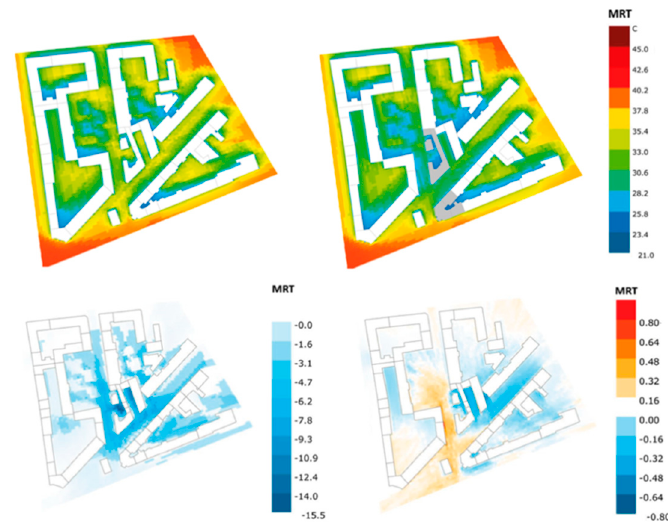
Figure 10. Twenty-four-hour MRT at street level for high-rise cluster for base case (top left) and densification scenario (top right) and 12-h MRT differences at street level between base case and densification scenario for smaller sample area for daytime ( left ) and nighttime ( right ).